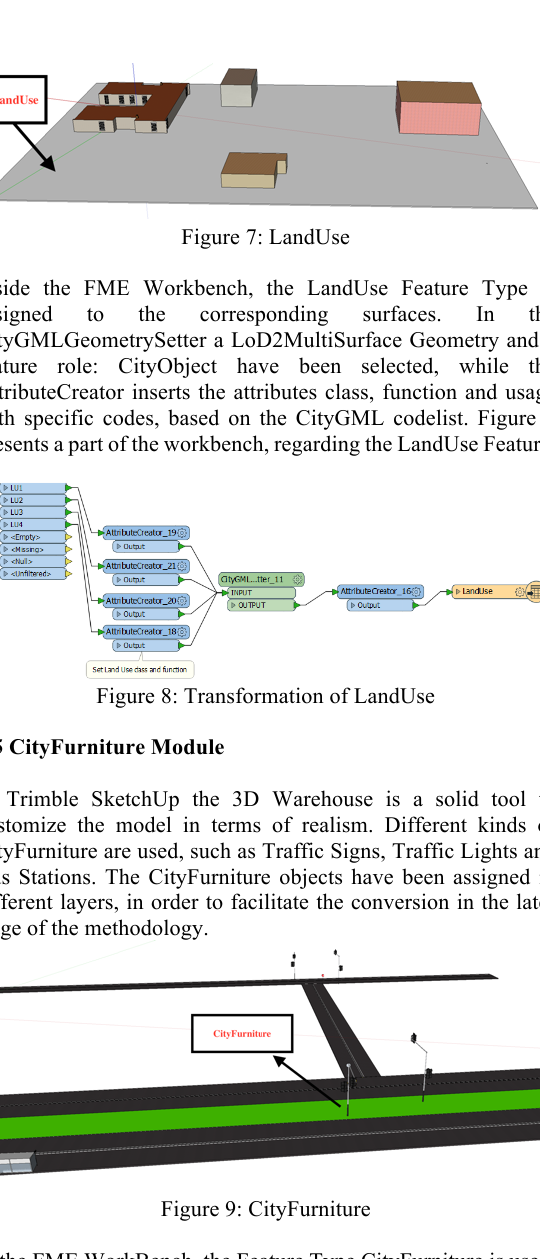
Figure 6: Conversion of the